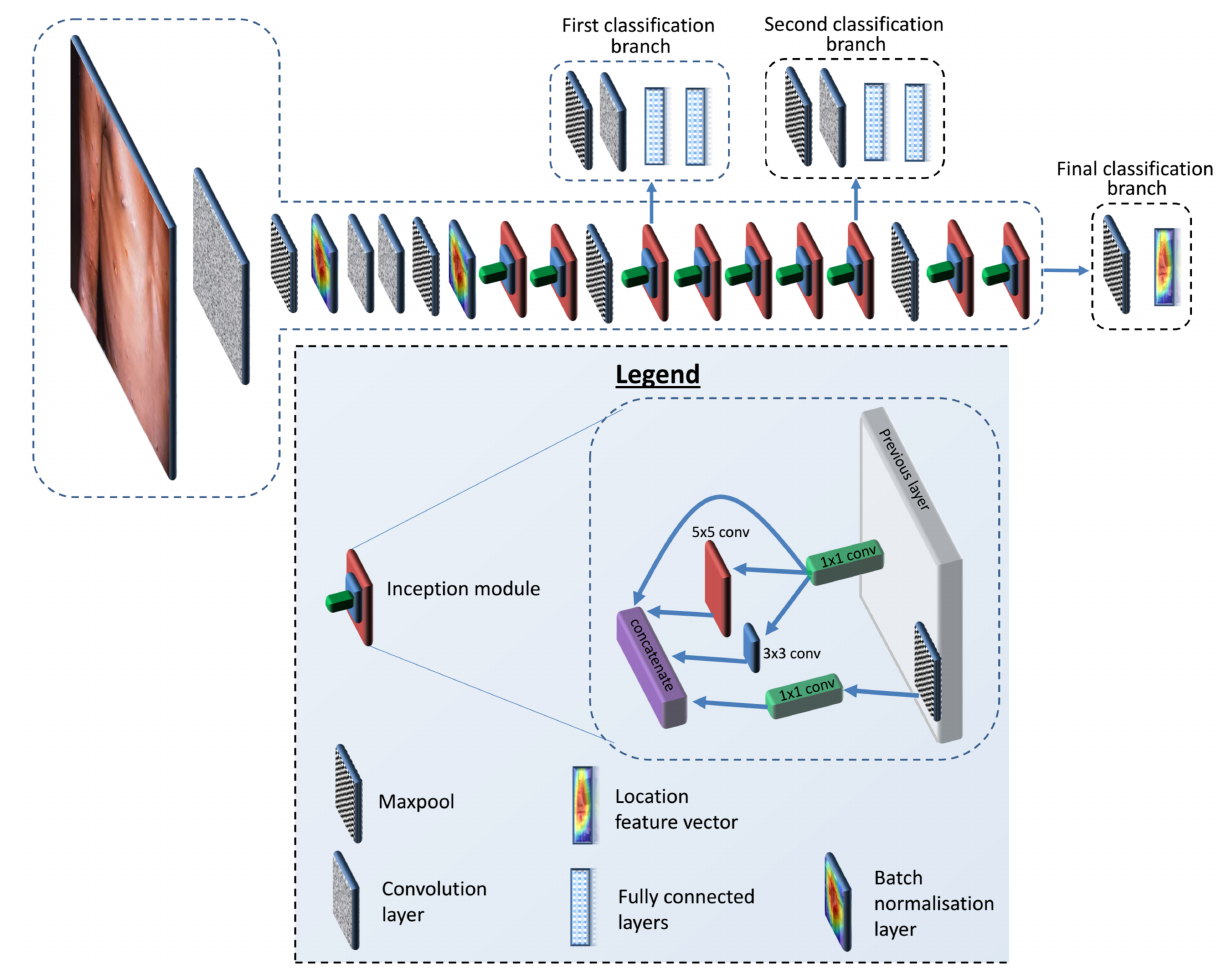
Figure 1. Architecture of GoogleNet, the deep network employed for feature extraction based on transfer learning.